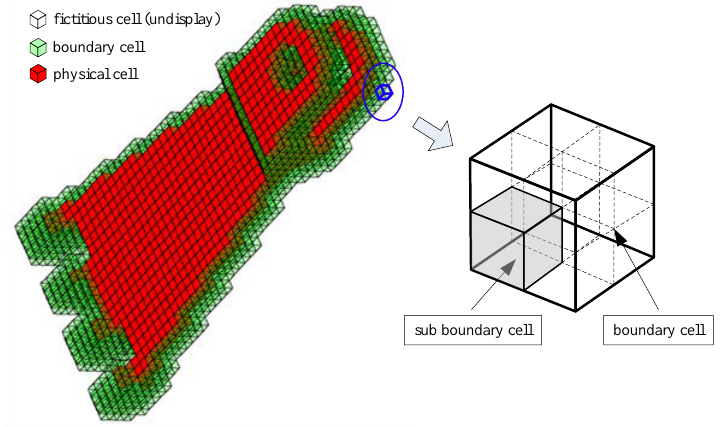
Figure 7. Grid identification and refinement for the lifting lug in the fixed grid.